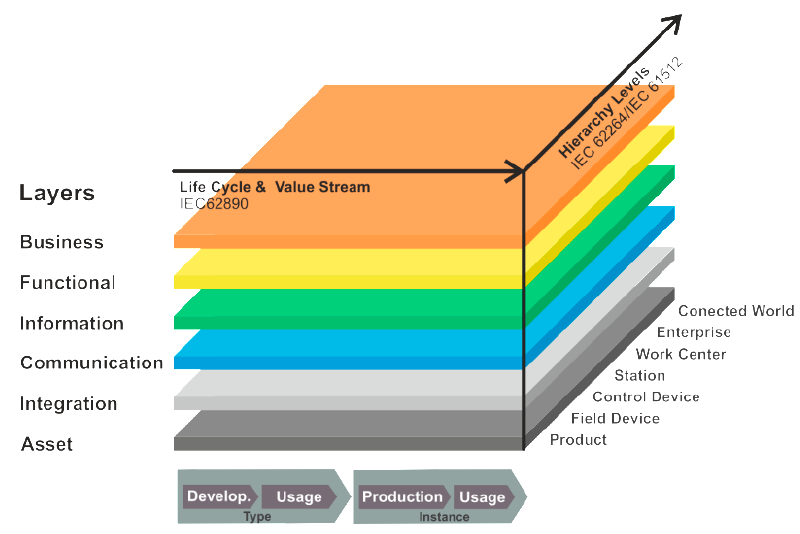
Figure 1. The RAMI 4.0 metamodel (inspired by ZVEI and VDI/VDE [17]).